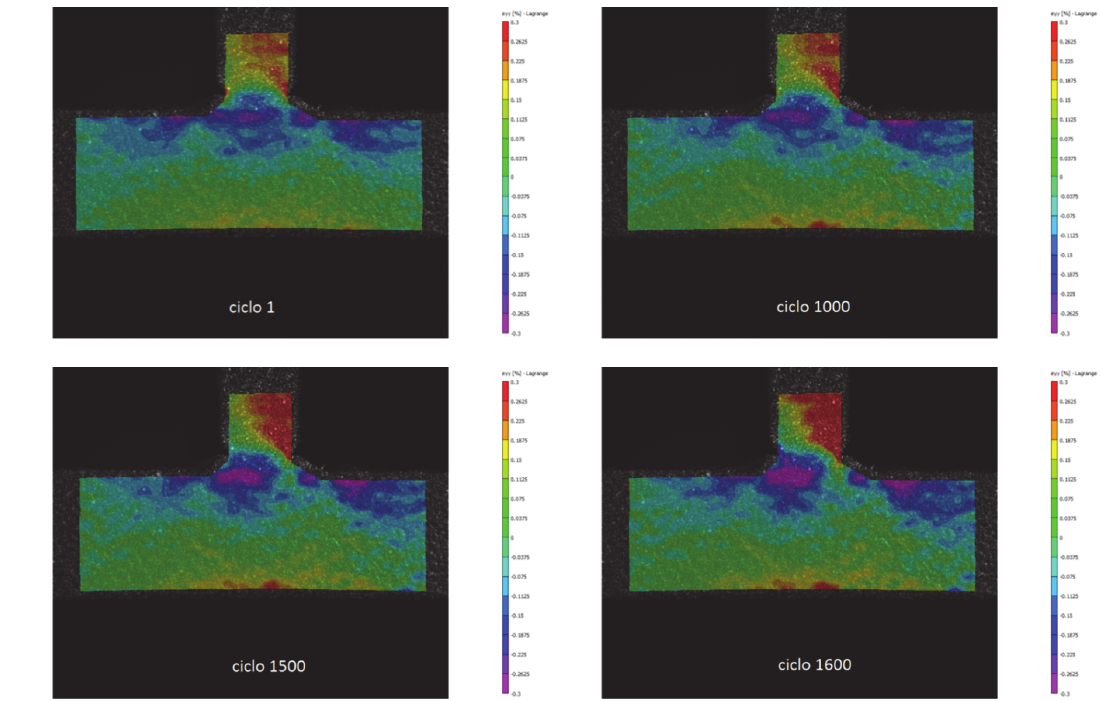
Figure 8: Vertical strain ( ε y ) measured at maximum load (40 kN) using the digital image correlation for different load